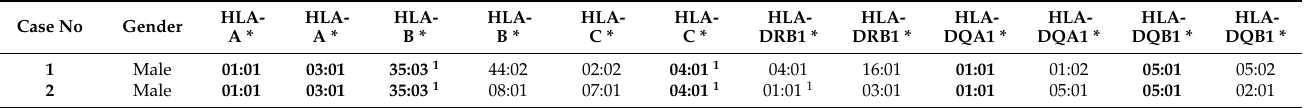
Table 2. HLA genotyping results of the presented